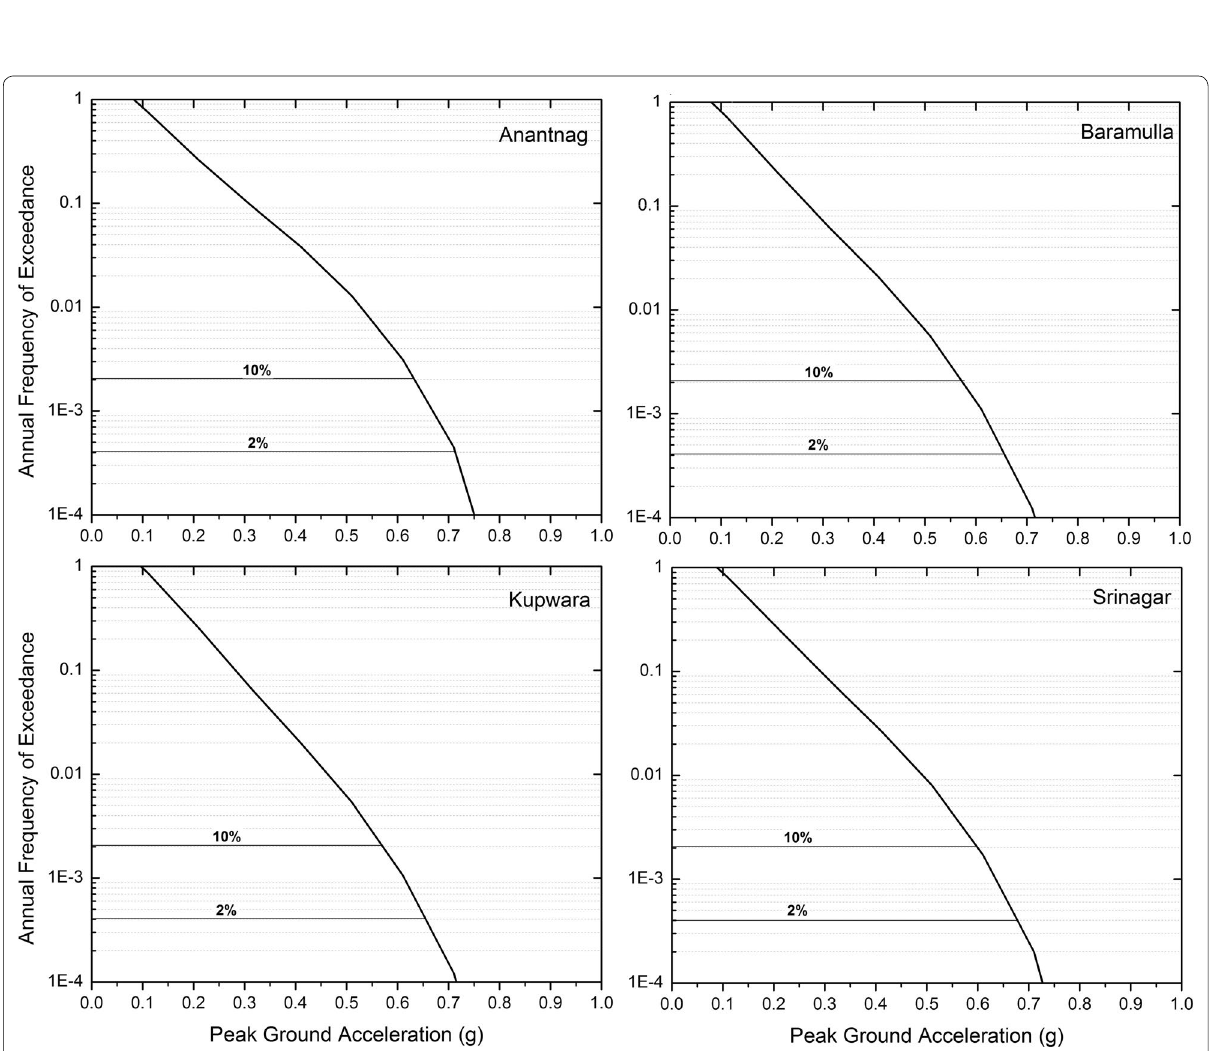
Fig. 5 The seismic hazard curve for predicted peak ground acceleration (PGA) in g for Anantnag, Baramulla, Kupwara and Srinagar, the major towns of Kashmir basin, showing 2% and 10% probability in 50 years for engineering bed rock